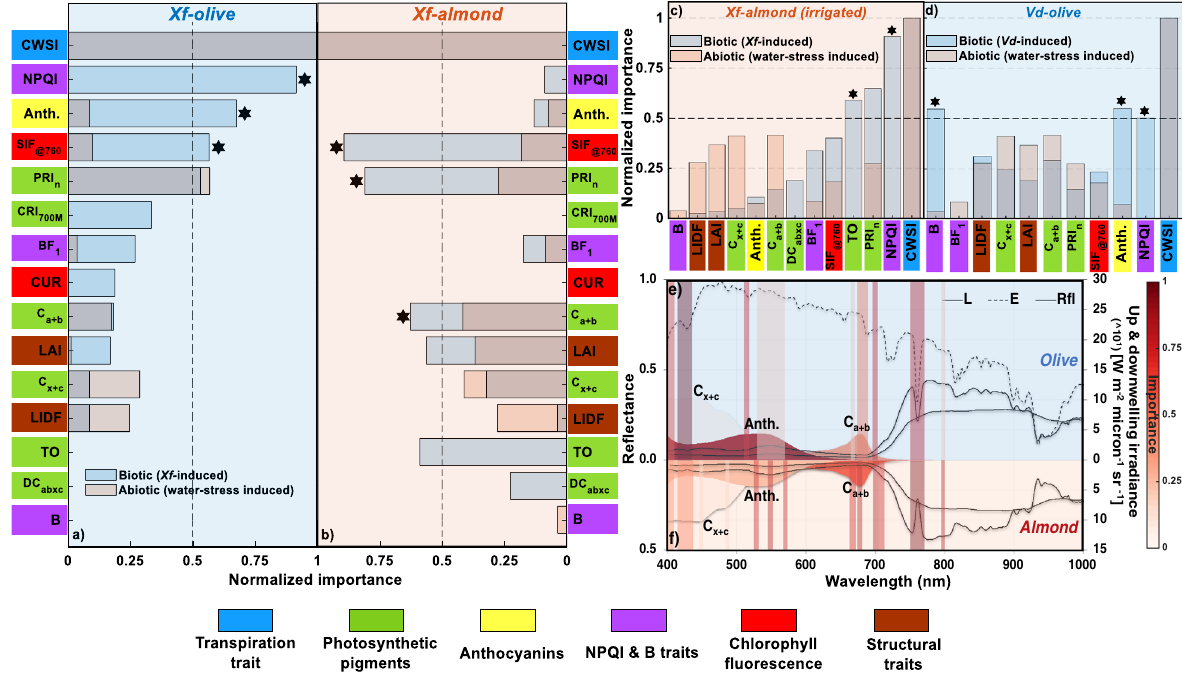
Fig. 4 Importance of spectral plant traits for Xf - and Vd -detection across species under simultaneous biotic and abiotic stress. Spectral plant traits that diverge under biotic and abiotic stress are indicated with black stars for Xylella fastidiosa ( Xf ) infection, in olive ( a ) and almond trees ( b , c ) and for Verticillium dahliae ( Vd ) infection in almond trees ( d ). The particular case of Xf -infected almond trees grown under non-water-limited conditions is shown in c . Importance of the different spectral regions for Xf detection in olive ( e ) and almond ( f ) trees showing the spectral radiance (L), irradiance (E) and re fl ectance (R fl ). The importance of each predictor was obtained by the permutation of out-of-bag (OOB) predictor methodology when classifying both biotic and abiotic stress-induced conditions using a random forest algorithm. The importance of each spectral trait was normalised by the highest importance obtained for each pathogen/species. Statistical analysis was carried out using a balanced training set obtained from the indicated number of trees: n biotic = 7296 and = 5484 ( a ); n = 4048 and n = 3652 ( b ); n = 2680 and n = 3652 ( c ); n = 1878 and n = 5848 ( d n abiotic biotic abiotic biotic abiotic biotic abiotic